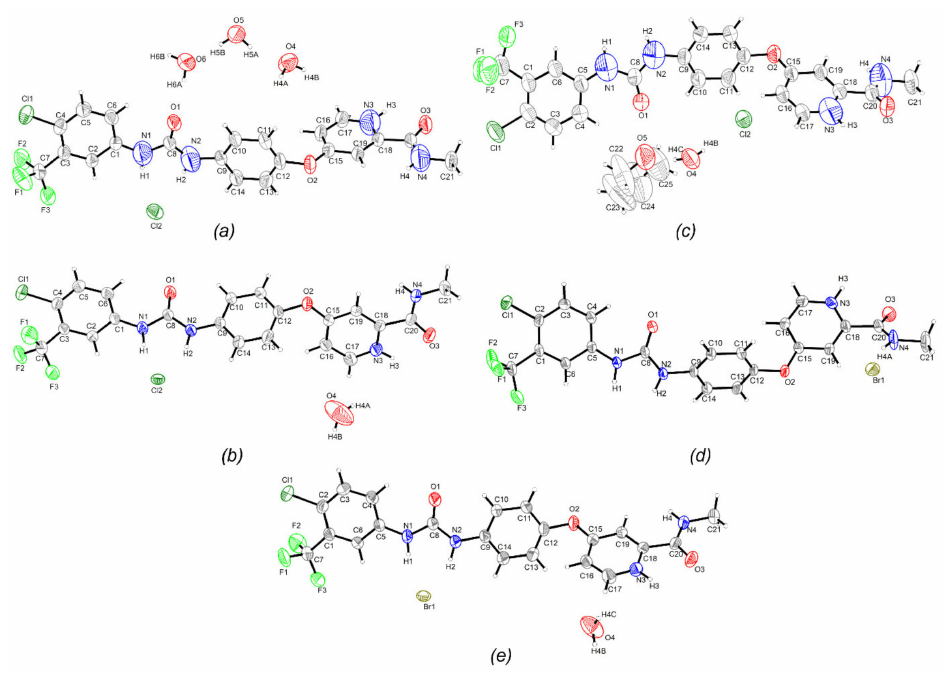
Figure 3. The asymmetric unit of ( a ) (I), ( b ) (II), ( c ) (III), ( d ) (IV) and ( e ) (V) with the atom-labelling scheme. Displacement ellipsoids are drawn at a 50% probability